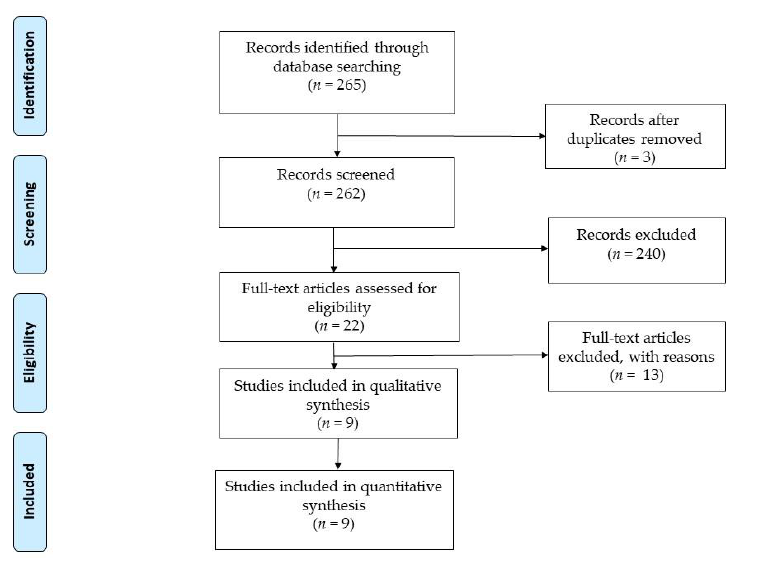
Figure 1. Flow char.